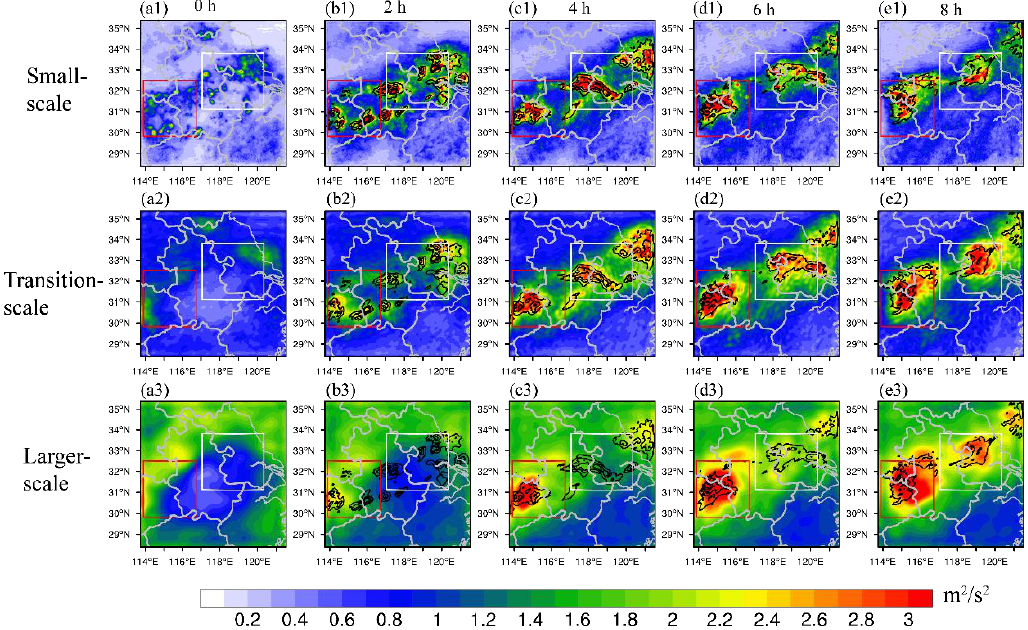
Figure 5. Distribution of RMDTE (color) at different spatial scales (first row) small-scale, (second row) transition-scale, (third row) larger-scale, and 1-h accumulated precipitation (contour) at different valid times ( a1–a3 ) 0 h, ( b1–b3 ) 2 h, ( c1–c3 ) 4 h, ( d1–d3 ) 6 h, ( e1–e3 ) 8 h.